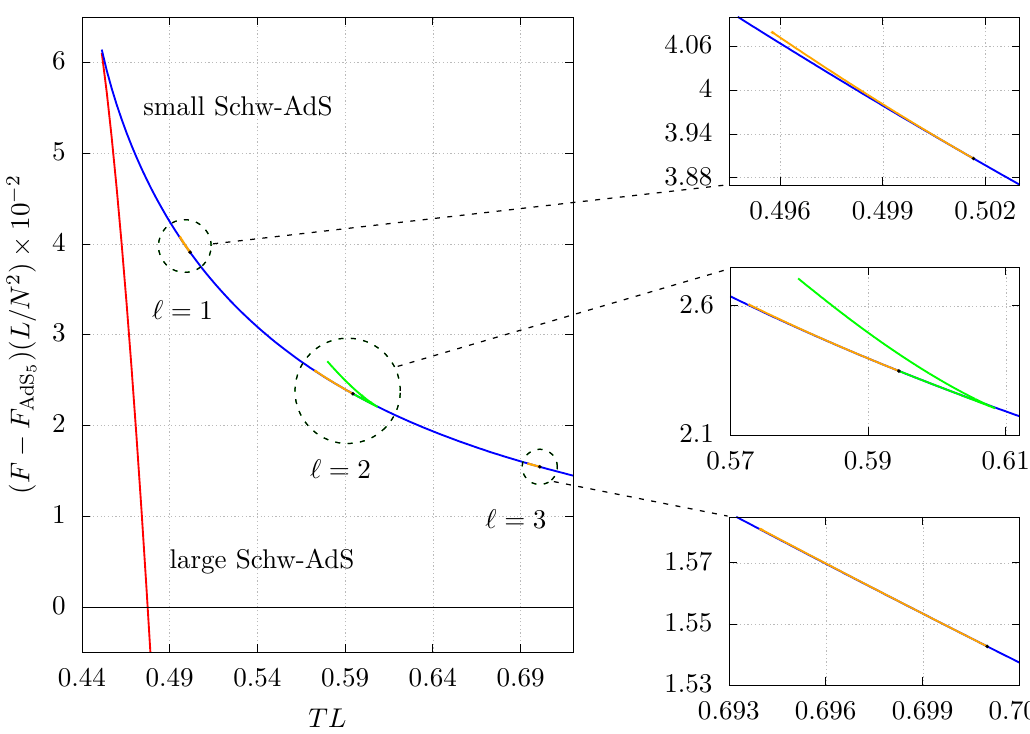
Figure 4. Phase diagram in the canonical ensemble containing all asymptotically AdS 5 × S 5 spacetimes that we consider in this paper. The GL threshold point for the various modes is indicated with a solid black disk. The zero of the free energy is taken to be the background thermal AdS which has free energy F = 3 N 2 / (16 L ) . All lumpy black holes are subdominant, even though the AdS ‘ = 2 − family has lower free energy than the small Schwarzschild-AdS 5 × S 5 black hole for some